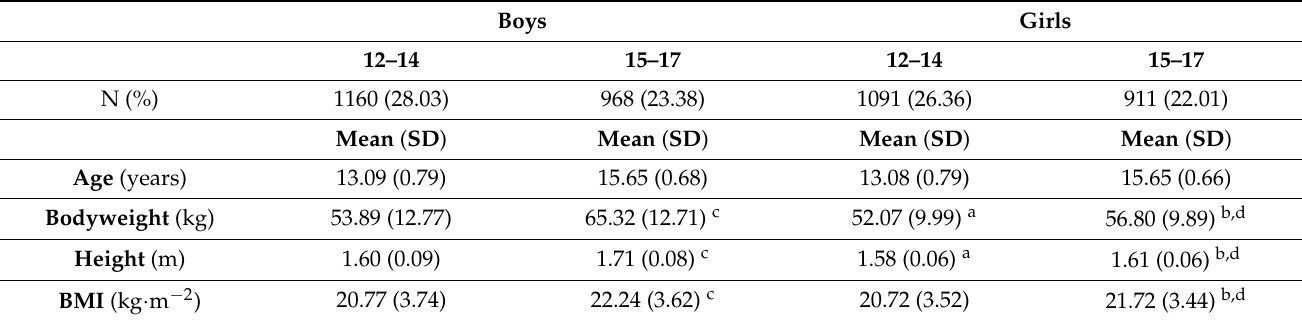
Table 2. Characteristic and anthropometry of participants segmented by age group and sex.